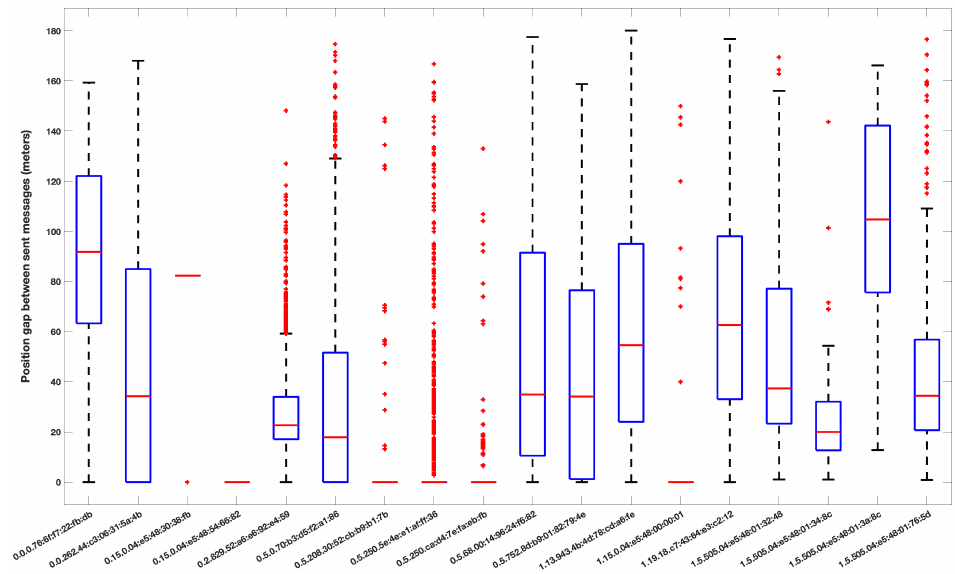
Figure 7. Representation of all steps distance between the received messages in the first tests.